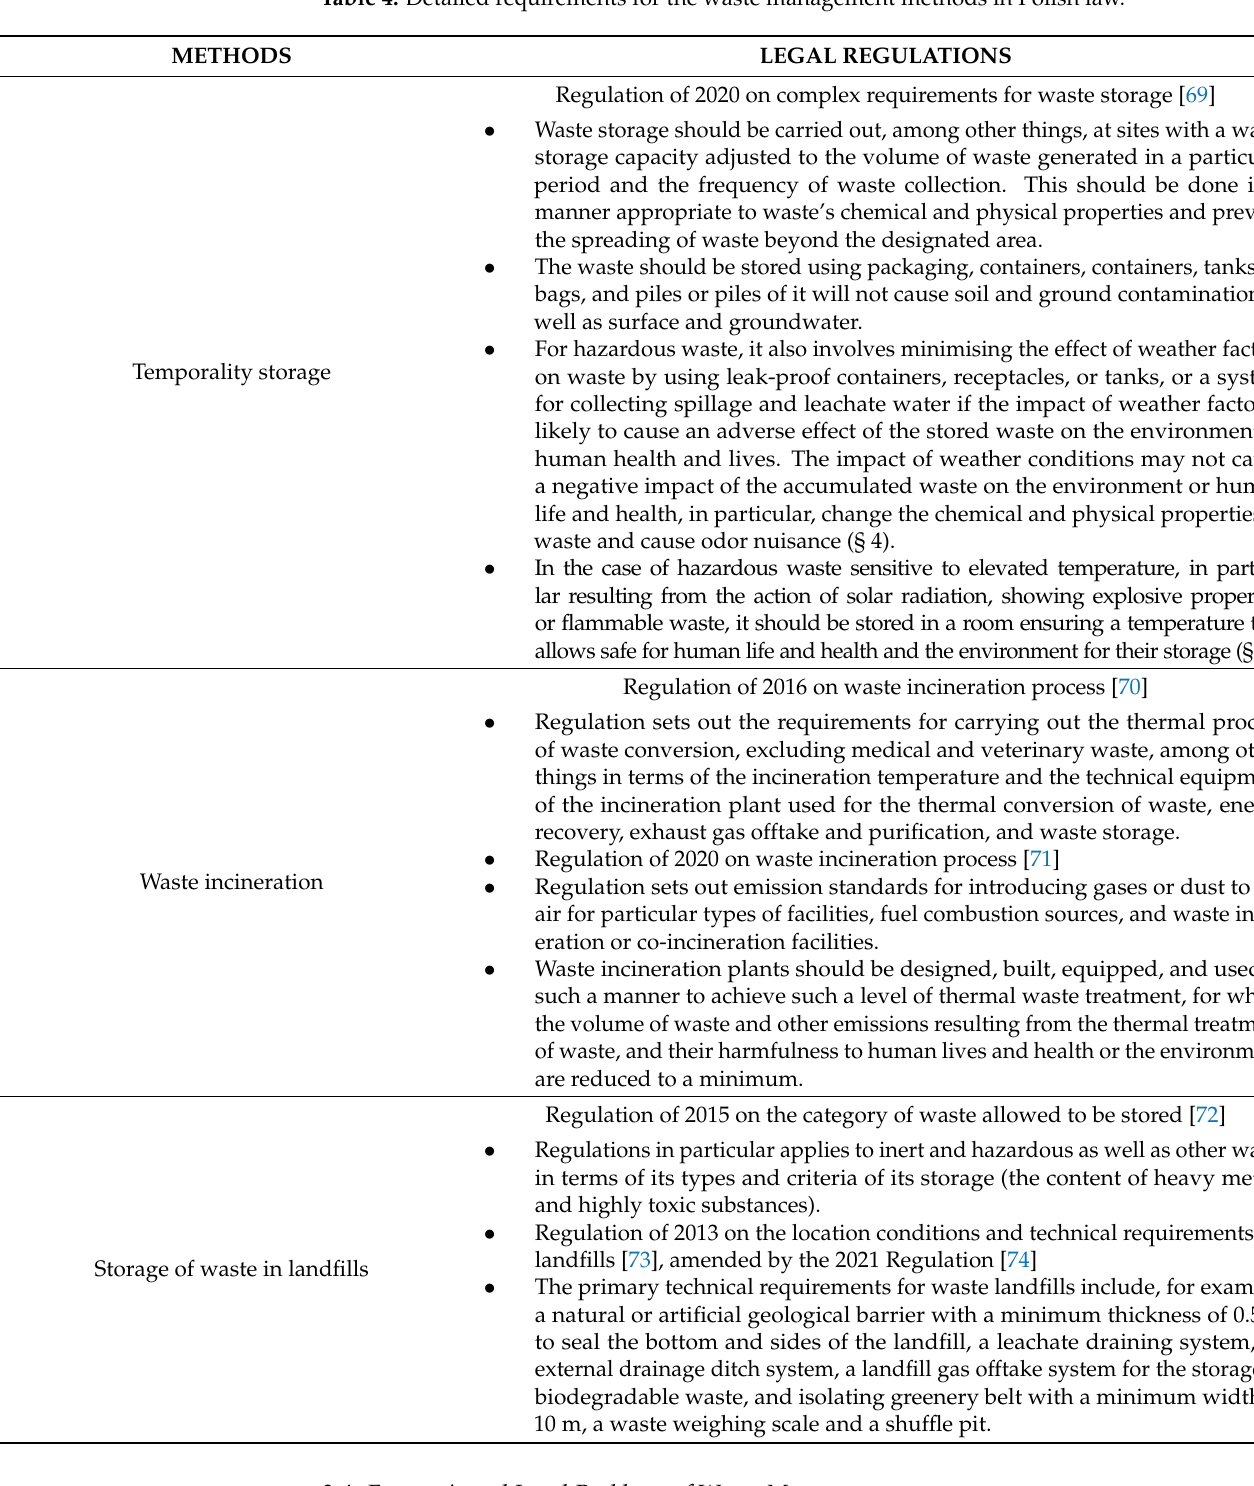
Table 4. Detailed requirements for the waste management methods in Polish